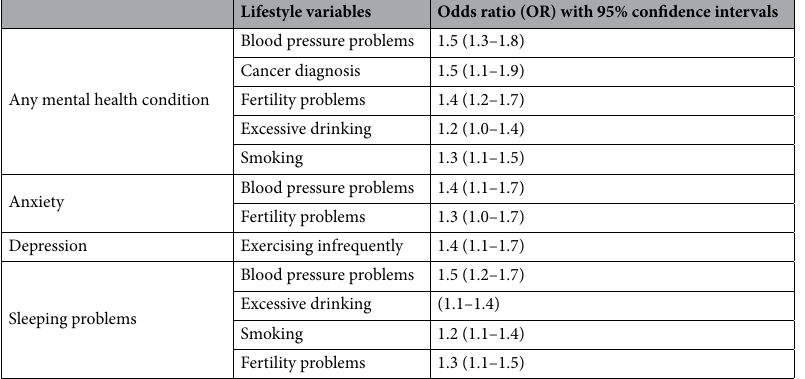
Any mental health condition